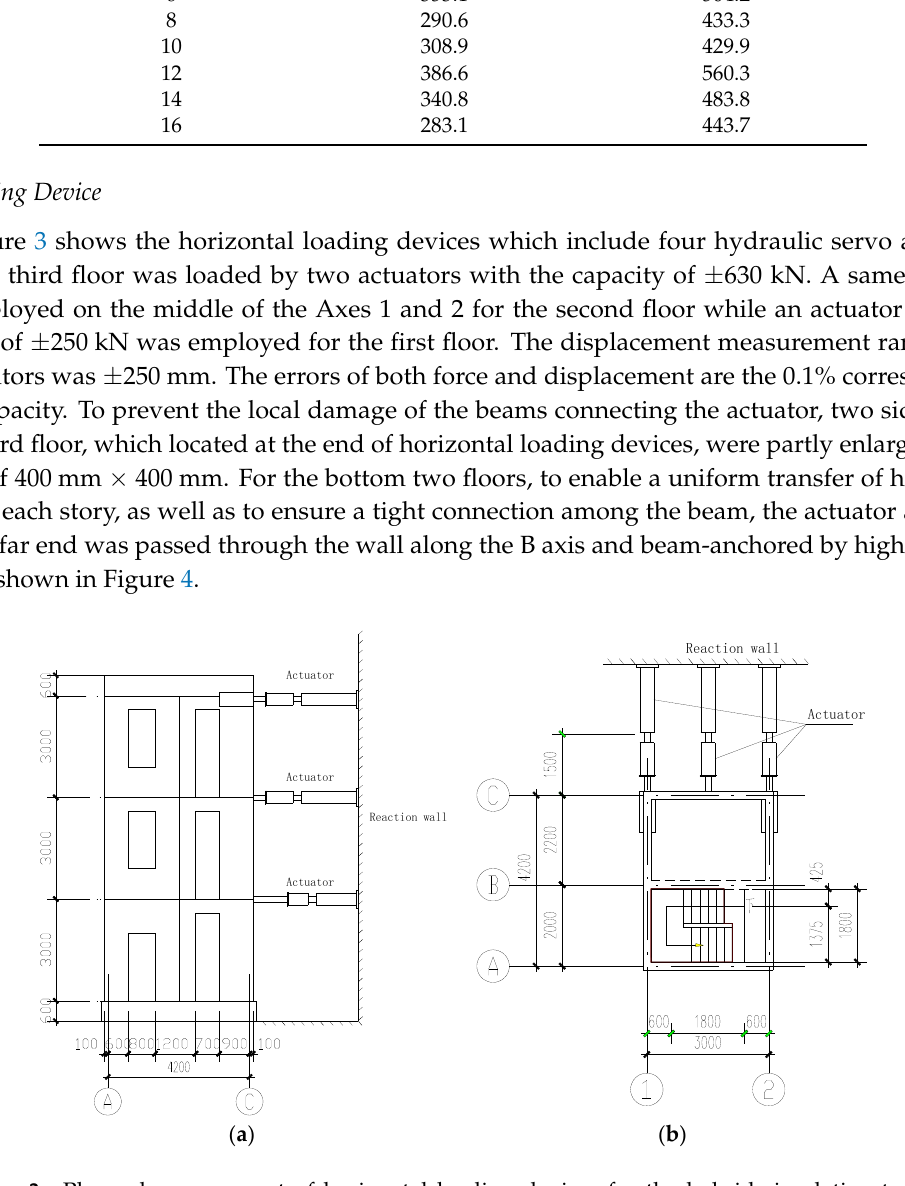
Table 3. Material properties of the steel reinforcement.